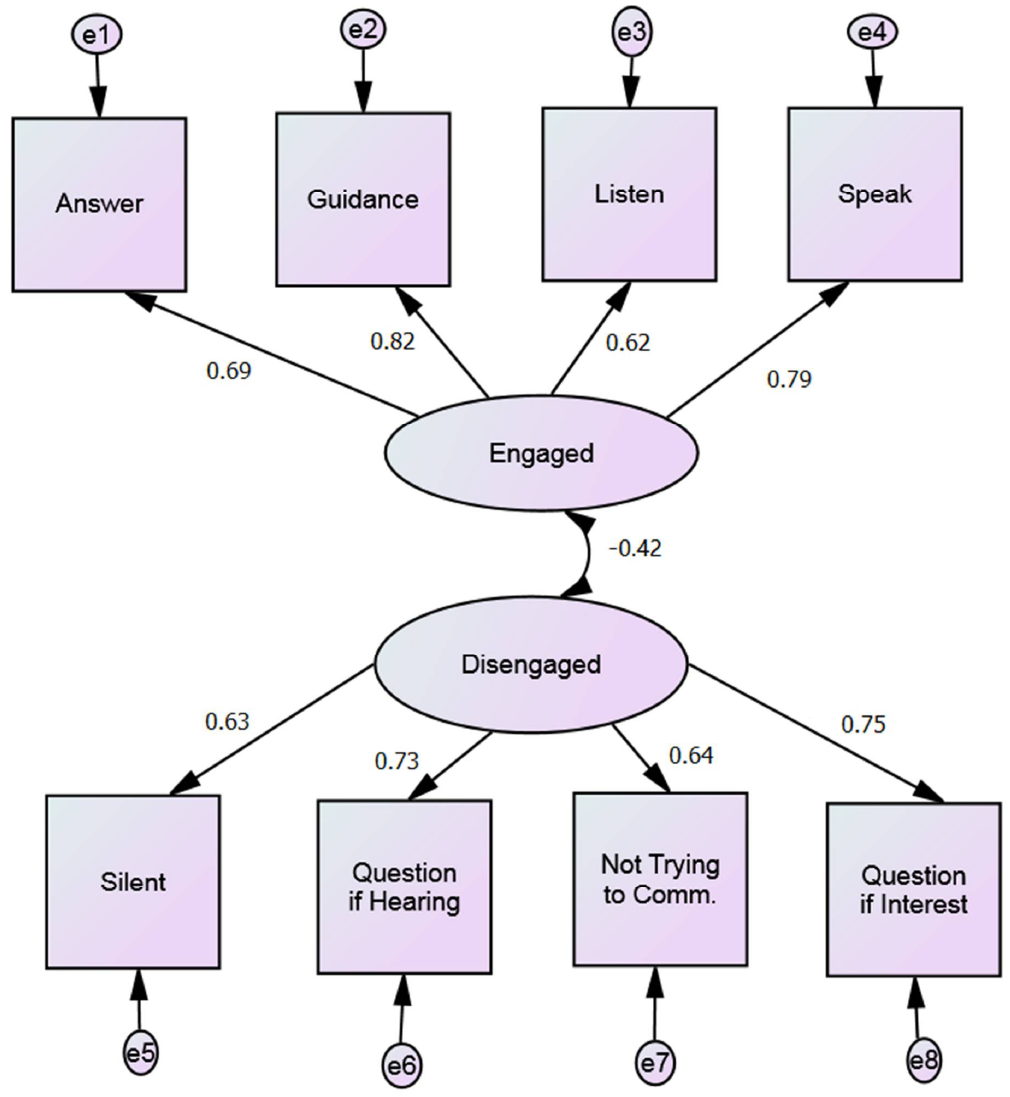
Figure 1. Confirmatory Factor Analysis on Divine Engagement and Disengagement Items (Sample 2). χ 2 (19, N = 413) = 65.517, p = 0.000, CFI = 0.958, RMSEA = 0.077, SRMR = 0.052, and PCLOSE = 0.014.